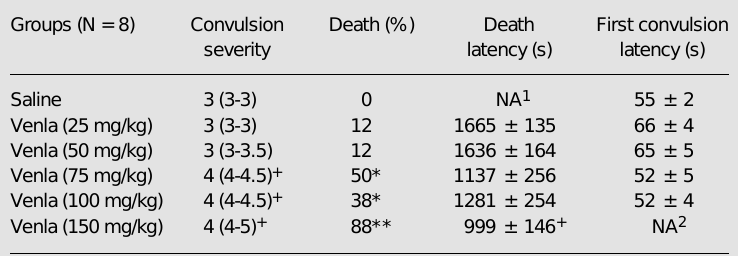
Latencies to death and to first convulsion are expressed as mean ± SEM and convul- sion severity as median with range in parentheses. NA 1 = not available; no animal in this group died during the cut-off time to 1800 s. NA 2 = not available; all animals in this group developed seizures prior to pentylenetetrazole administration. Venla =